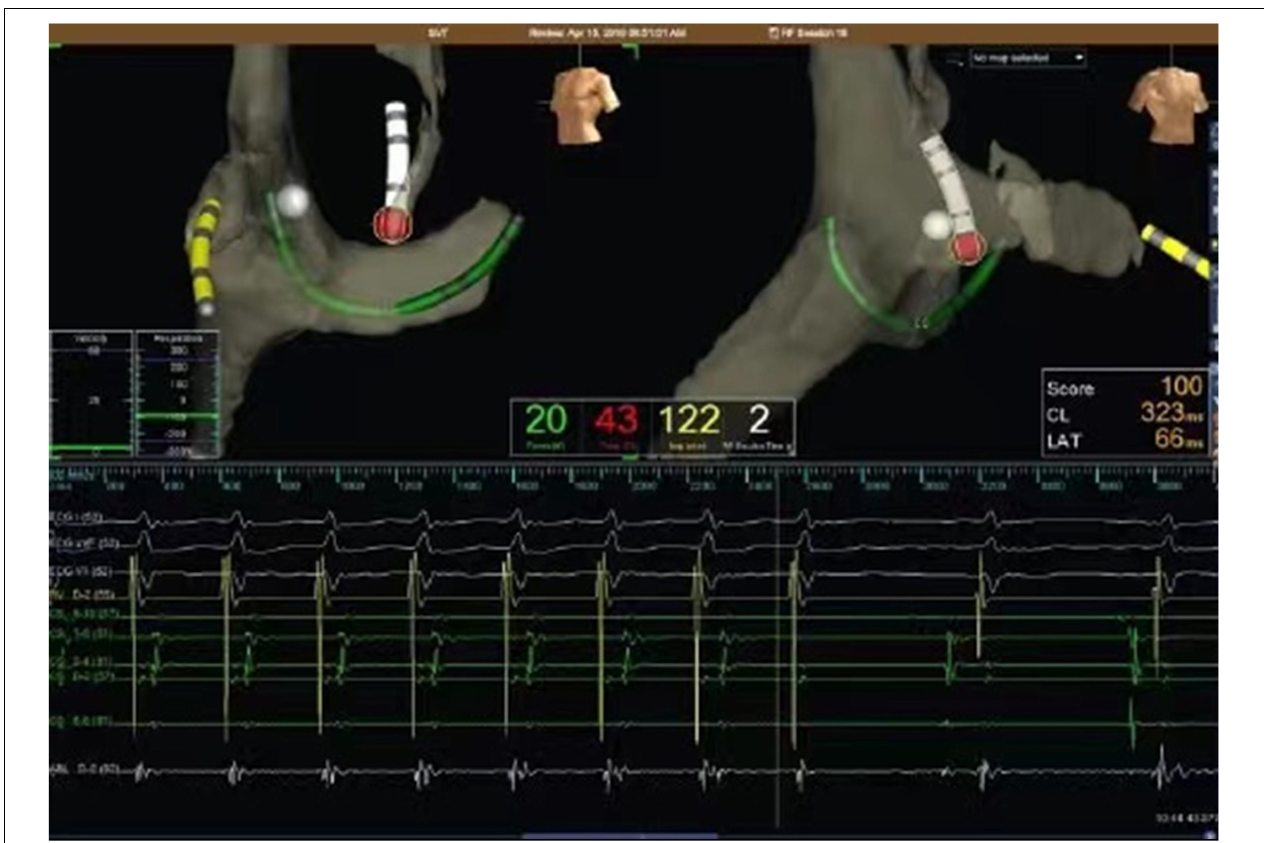
FIGURE 2 | Representative electroanatomical map during ablation of left -sided AP via TS in a child. Catheters were placed under the guidance of NAVX after successful puncture, showing a small A and a large V, having AV fusion during ventricular pacing. The w hite tag represents the His region, while red tag represents ablation point. AV separation indicates that ablation is effective. AV separation indicates that ablation is